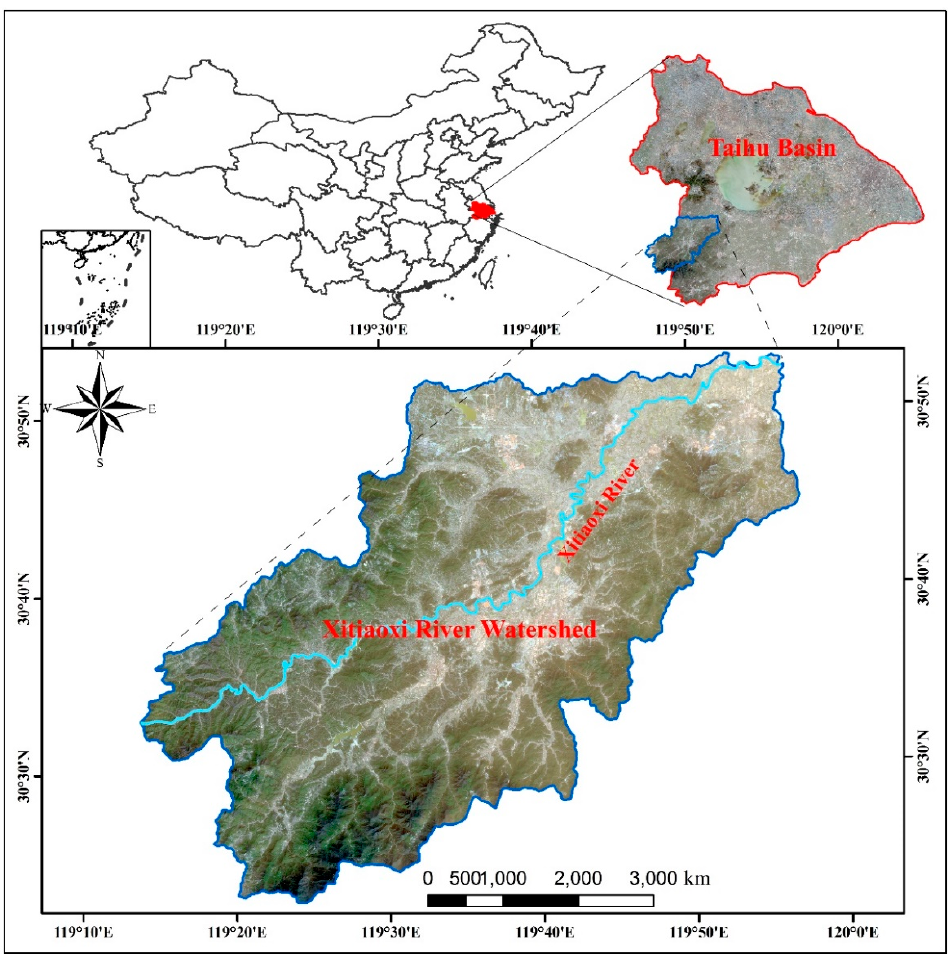
Figure 1. Location of the Xitiaoxi watershed and Taihu Basin. The Sentinel-2 Multispectral Instrument (MSI) imagery is shown with true-color composite of Red, Green, and Blue bands in Bottom-of-Atmosphere reflectance data.